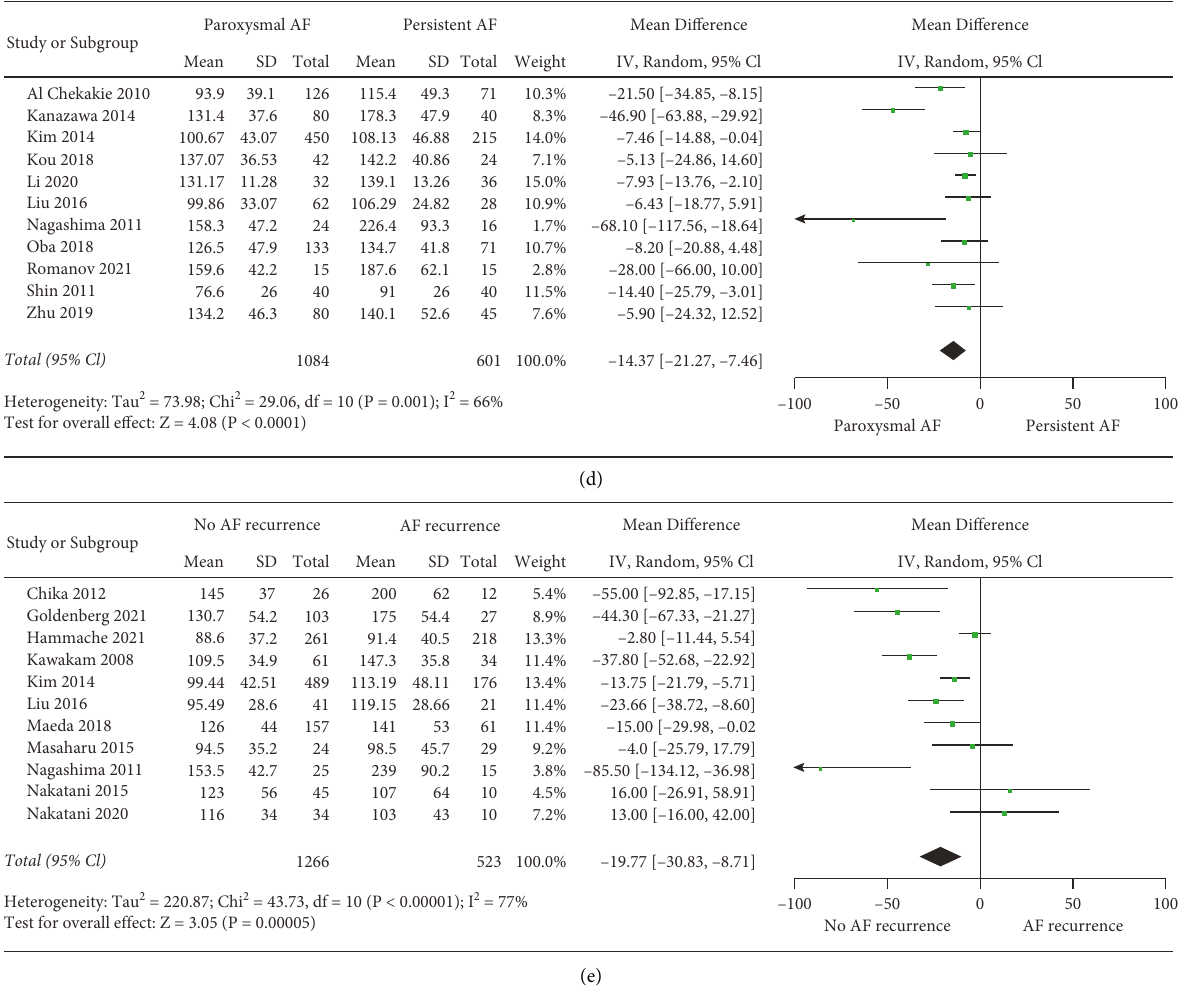
Figure 2: Forest map of EFT volume differences among different populations: (a) healthy participants and all AF cases; (b) healthy participants and paroxysmal atrial fibrillation; (c) healthy participants and persistent atrial fibrillation; (d) paroxysmal atrial fibrillation and persistent atrial fibrillation; and (e) recurrent and nonrecurring patients after